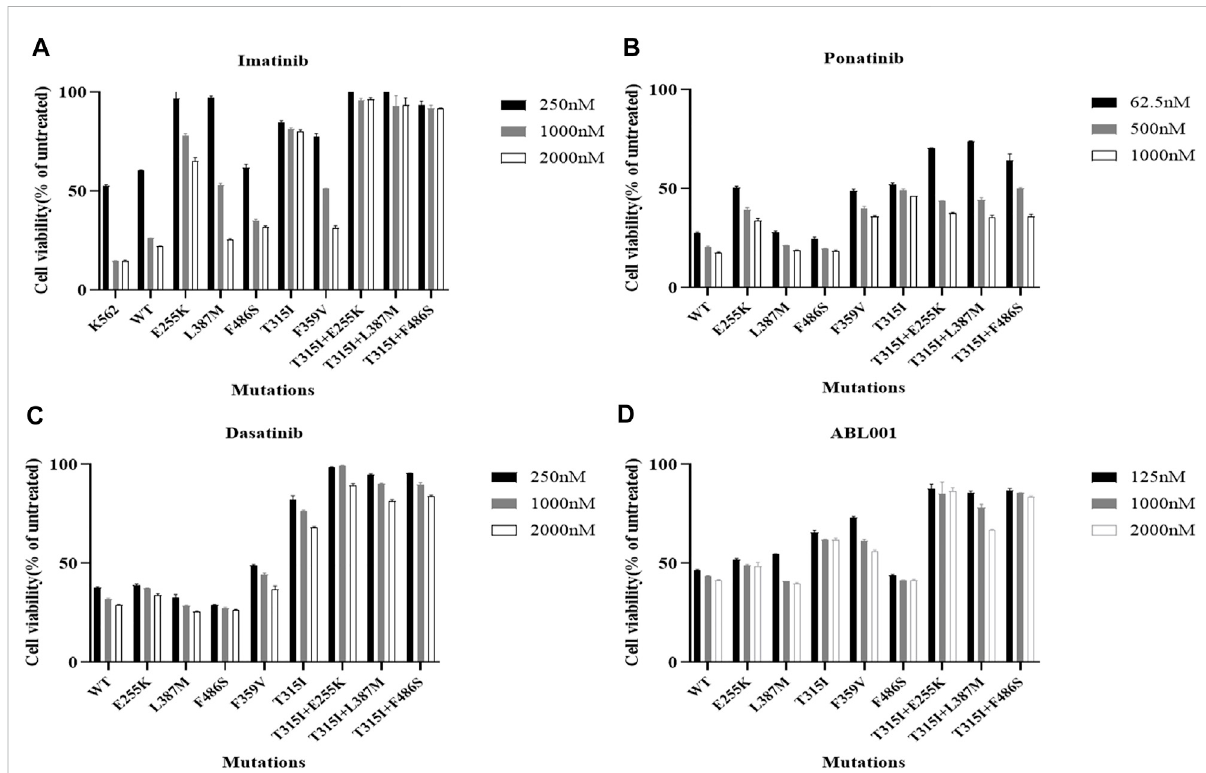
FIGURE 1 Effects of inhibitors targeting ABL1 on the growth inhibition of Ba/F3-MIG-p210 cells with BCR::ABL1 compound mutations were signi fi cantly weakened. The viability of Ba/F3-MIG-p210 cells treated with different concentrations of ABL1 inhibitor for 48 h was detected via the MTT assay: (A) imatinib, (B) ponatinib, (C) dasatinib, and (D)